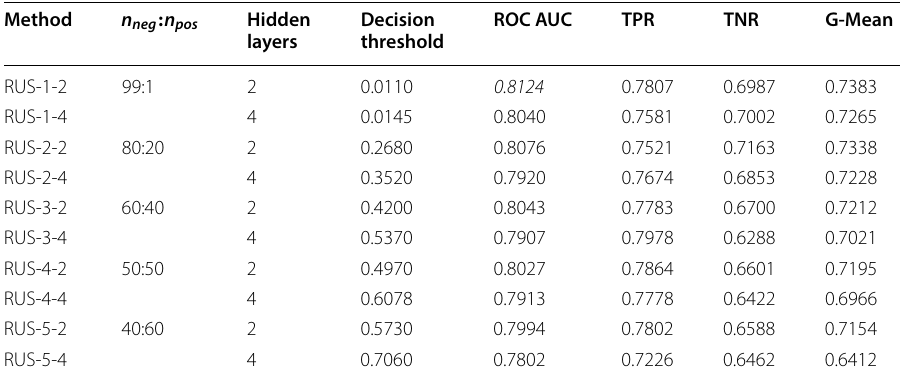
Table 13 Average RUS results (30 runs)